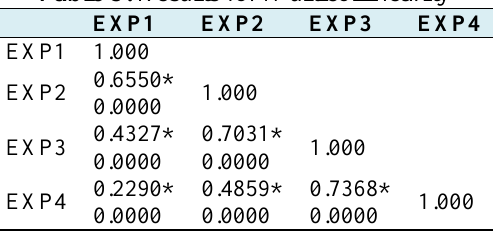
Table 3. Results for Multicollinearity